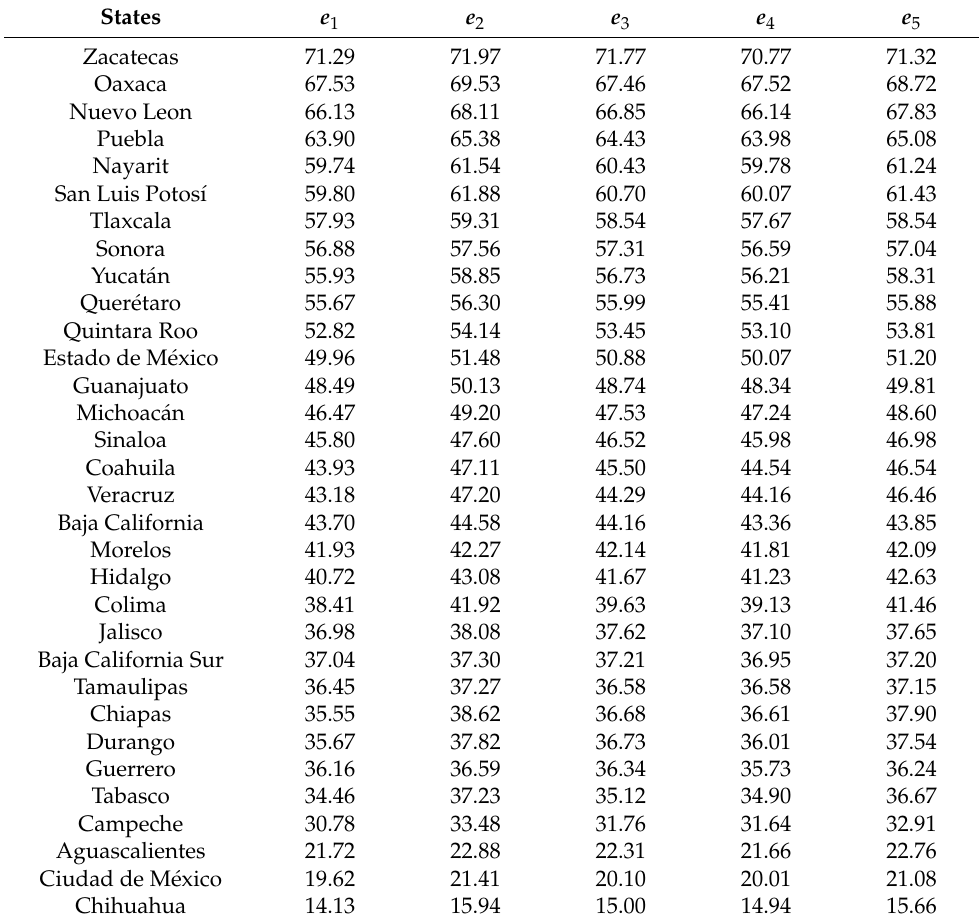
Table A3. Bon-IOWA operator results.